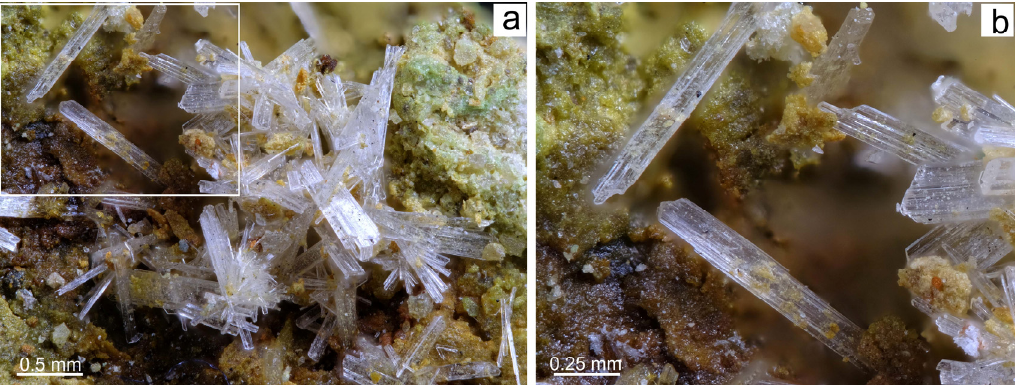
Figure 8. Optical images of gypsum crystals from the Mastricarro Barite Mine (Catanzaro, southern Italy): ( a ) aggregates of prismatic euhedral monoclinic crystals; ( b ) magnification of the rectangle outlined in ( a ) showing the parallel intergrowth.